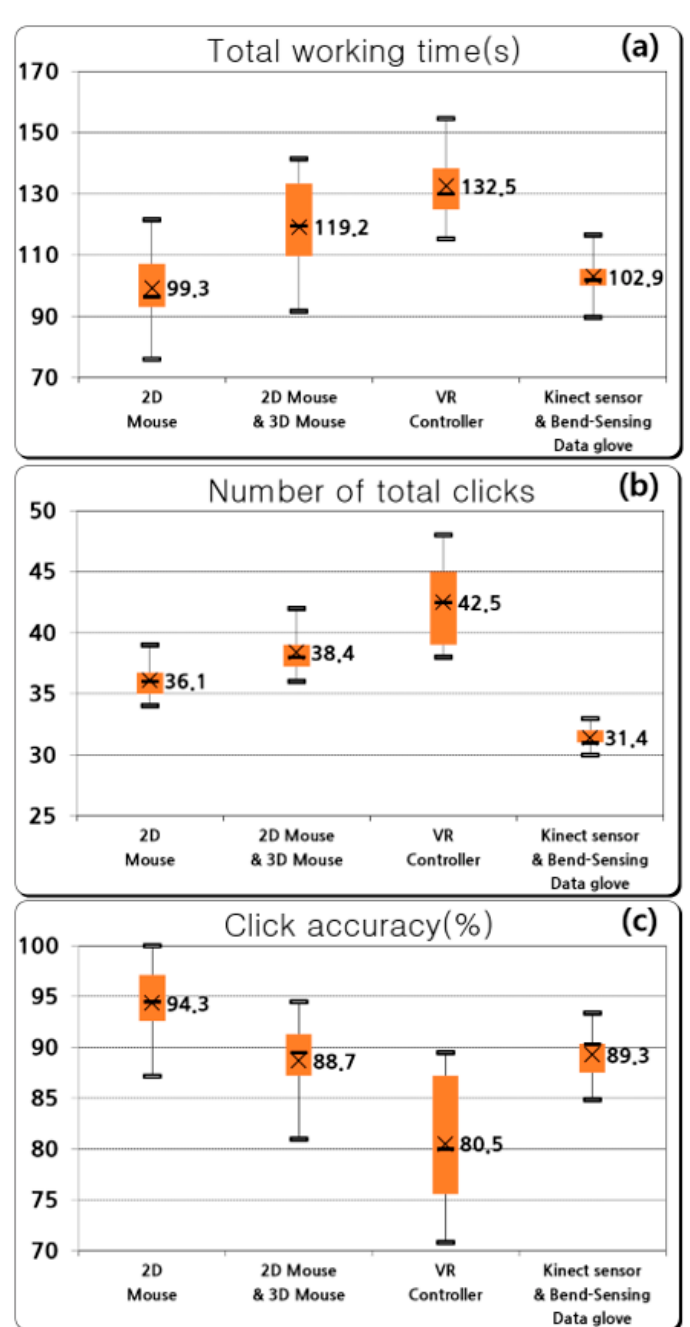
Figure 6. Results from experiments on controlling KmodStudio in a virtual reality (VR) environment using different user interface devices ( a ) Total working time; ( b ) number of total clicks; and ( c ) click accuracy.